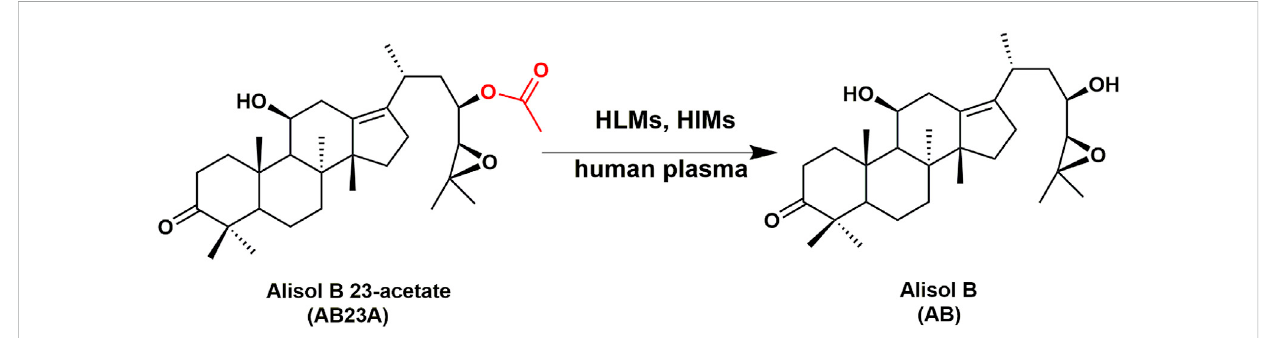
The hydrolytic pathways of AB23A in HLMs, HIMs and human